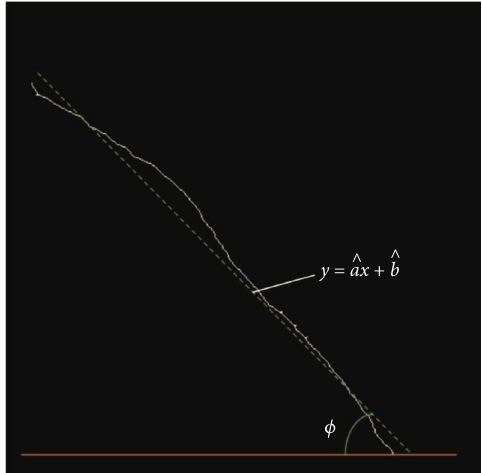
Figure 13: Fitting line of the